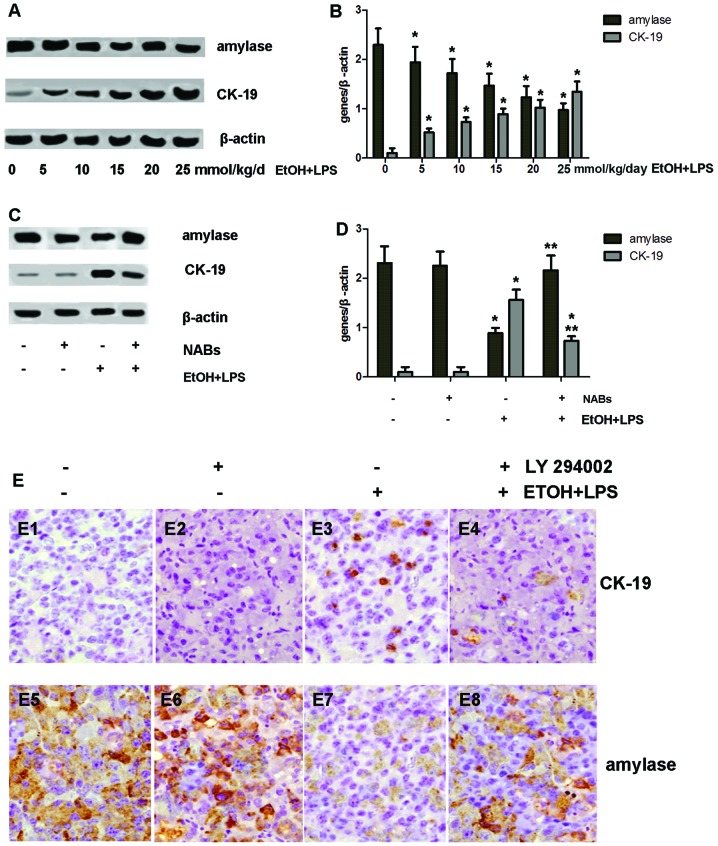
Pancreatic acinar-to-ductal metaplasia (ADM) was induced in rats by chronic alcohol [ethanol (EtOH)] and lipopolysaccharide (LPS) exposure. (A) Amylase expression was downregulated in pancreatic acinar cells with an enhancement in cytokeratin-19 (CK-19) expression. (B) Protein expression was analyzed using BandScan 5.0 software and normalized to β-actin; *P<0.05 vs. control (0 mM/kg/day). (C) Restoration of amylase expression was caused by neutralizing antibodies with the decreased expression of CK-19. (D) Protein expression was analyzed using BandScan 5.0 software and normalized to β-actin; *P<0.05 vs. control, **P<0.05 vs. EtOH + LPS group. (E) CK-19 and amylase expression in pancreatic sections was detected by immunohistology. Pancreatic ADM was blocked by LY294002 [phosphatidylinositol-3-kinase (PI3K) inhibitor].